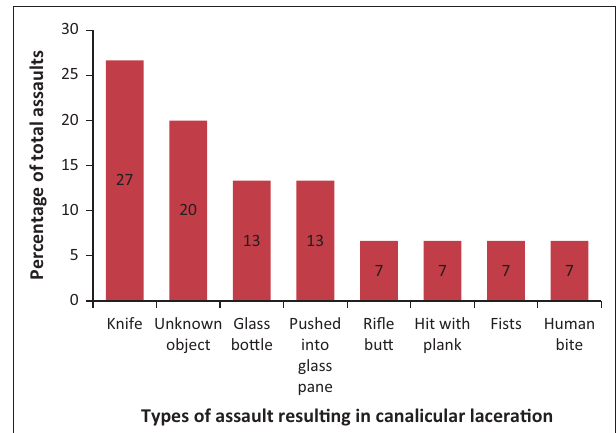
FIGURE 1: Major causes of canalicular injury.